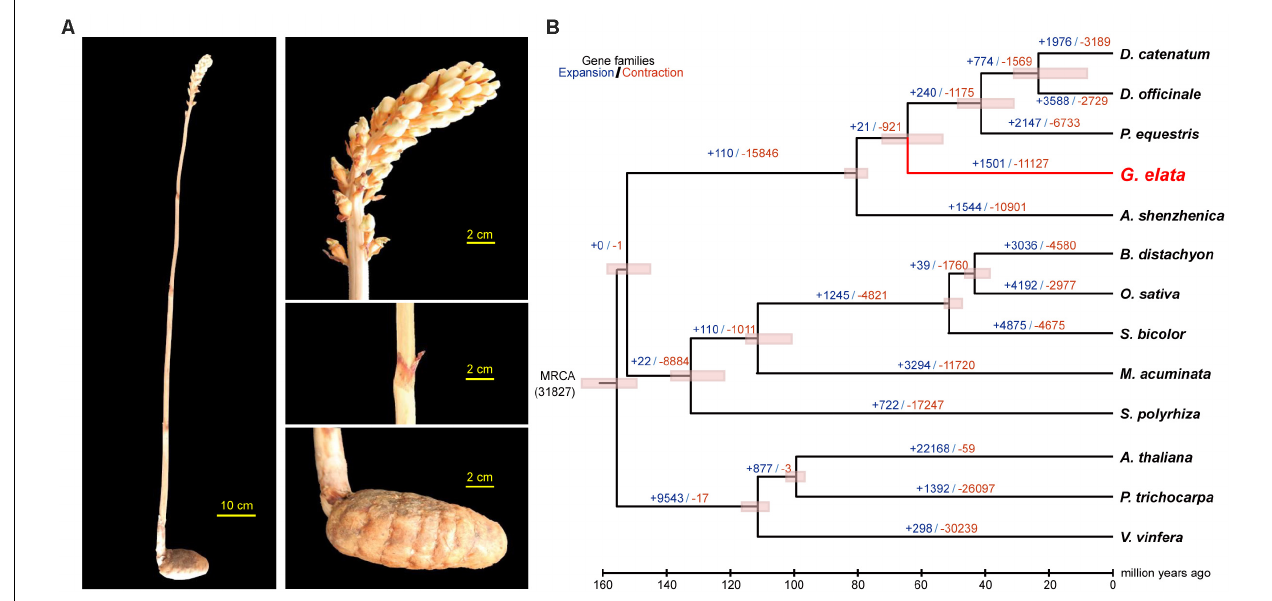
FIGURE 1 | Divergence time and morphology of G. elata . (A) Morphology of G. elata : photos showing a whole plant, flower, stem with degraded blade and tuber. (B) Divergence times are indicated by pink bars, expanded gene family numbers by dark blue letters and contracted gene families by orange letters.